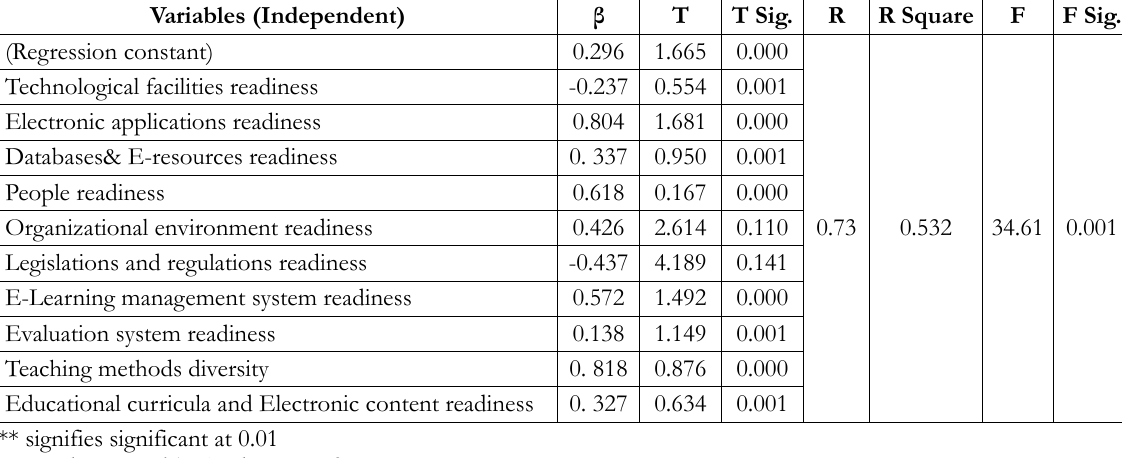
Table 6. Multiple regression between each dimension of E-Learning and the Students’ performance as a